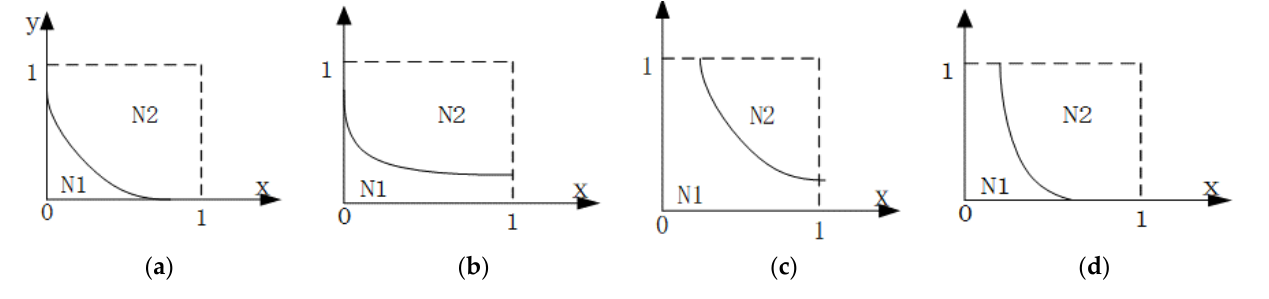
Figure 4. The intersection of the surface with the graph in the plane X-O-Y. Without loss of generality, we discuss the situation in Figure 4d.